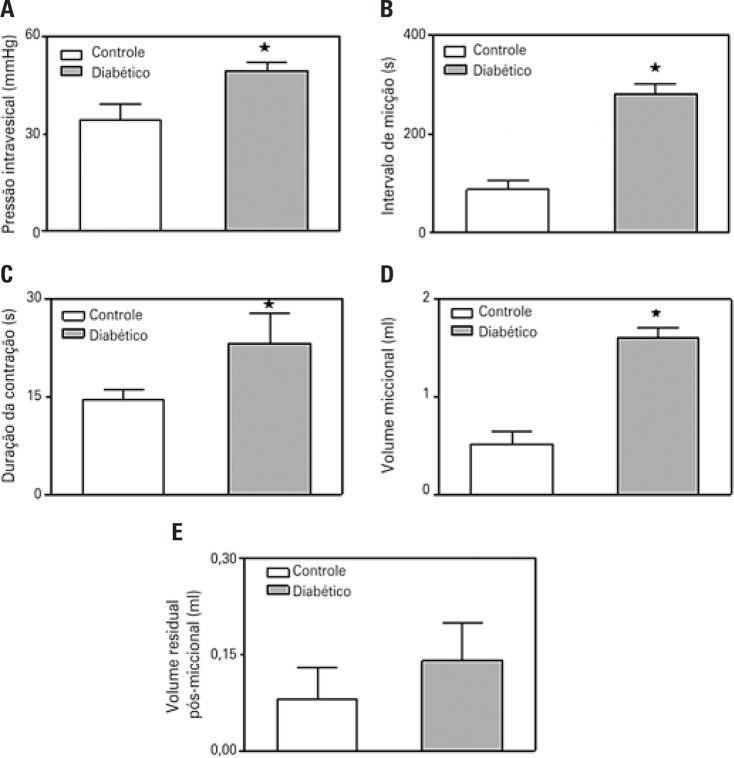
Valores (média±SEM) da pressão intravesical (A), intervalo (B), duração (C), volume de micção (D) e volume residual pós-miccional (E) em ratos não anestesiados (ratos controle e diabéticos). *p<0,05